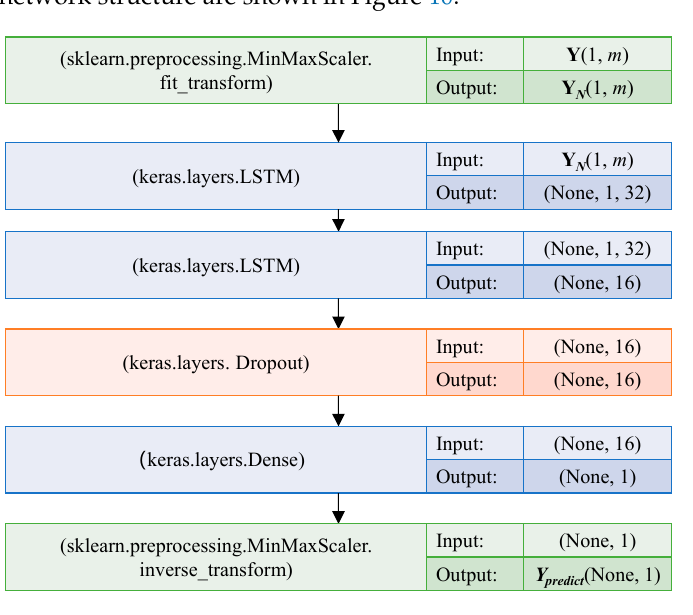
Figure 10. LSTM-optimized indicators combined model network structure.